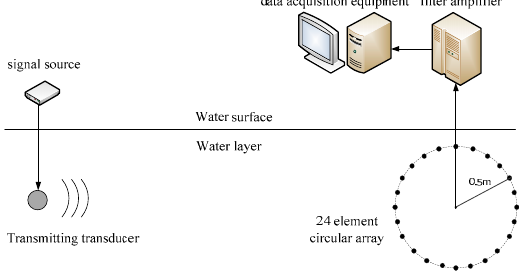
Figure 8. Block diagram of the water pool experiment.